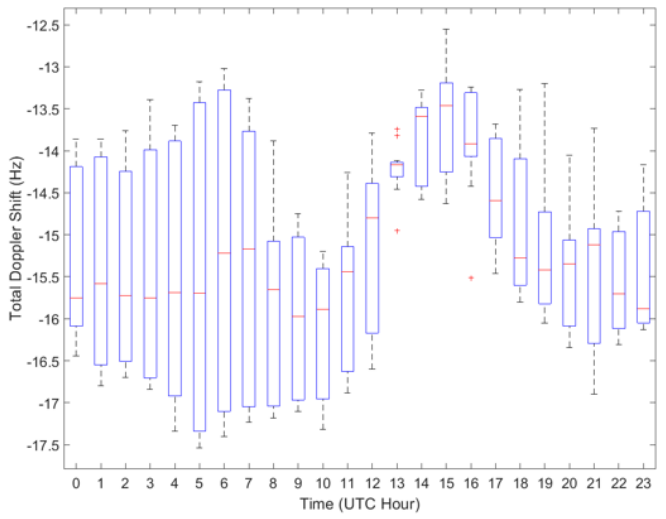
Figure 13. Nodes Total Doppler Shift vs. Time.